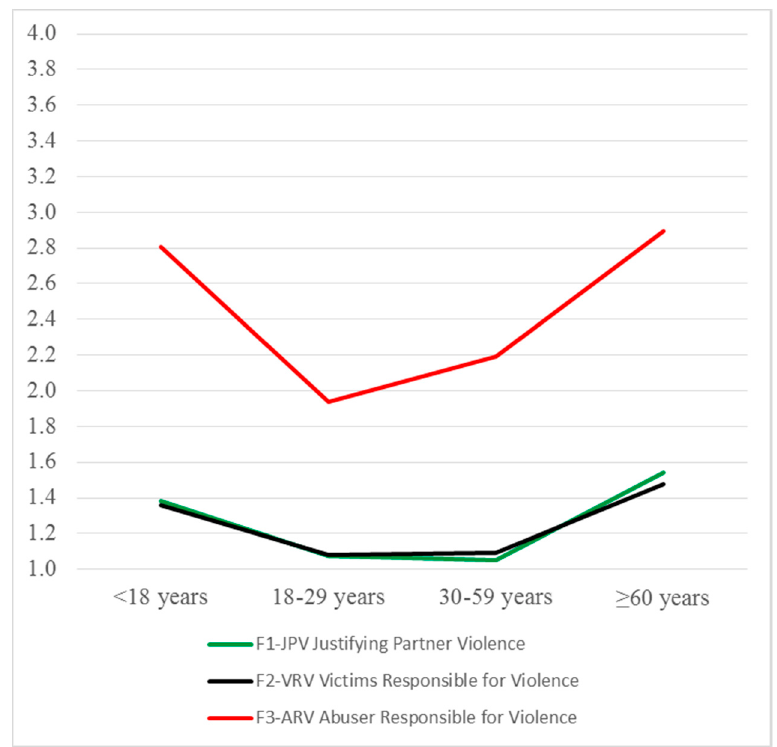
Figure 2. IBIPV: Means by age groups.